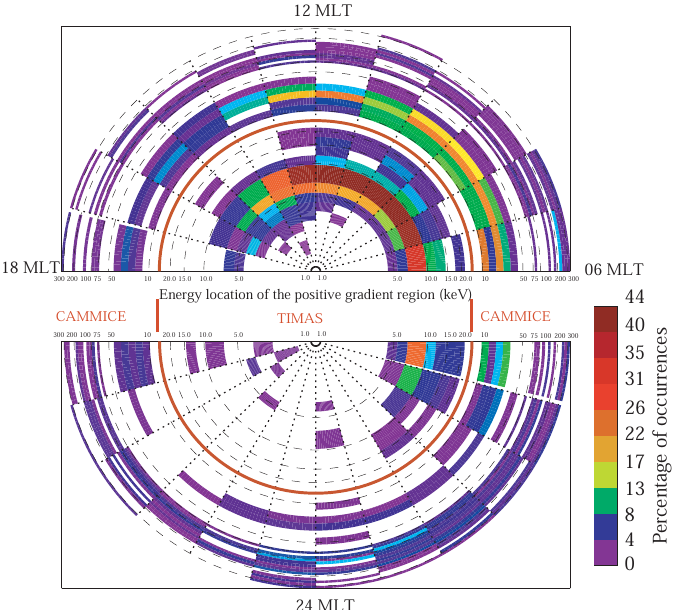
Fig. 6. Results of the study into the energy of the particles which contain free energy. As the radial distance from the centre of the circle is increased the energy of the particles which possess free energy (the W av parameter) increases. TIMAS data were examined for positive gradient regions between 1 and 21keV and CAMMICE (MICS) data were examined in a similar manner for regions between 10 and 325keV. The scale is logarithmic and the bin sizes are that of the instruments. The red line indicates the divide between the two instruments. Note there is an energy overlap between the two instruments. The data were binned according to MLT location. The data bins are colour coded as a percentage occurrence in that MLT